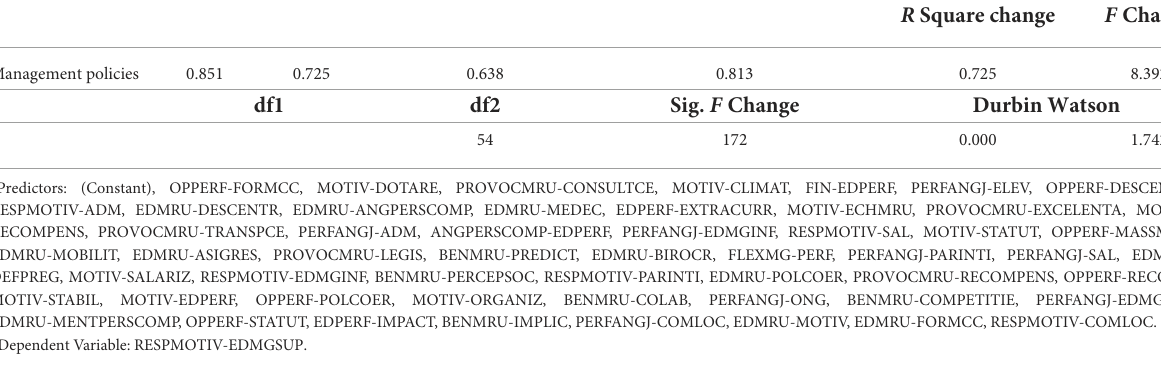
TABLE 4 Summary of the linear regression model on motivation as a determinant of the management policies. Model a , b R square